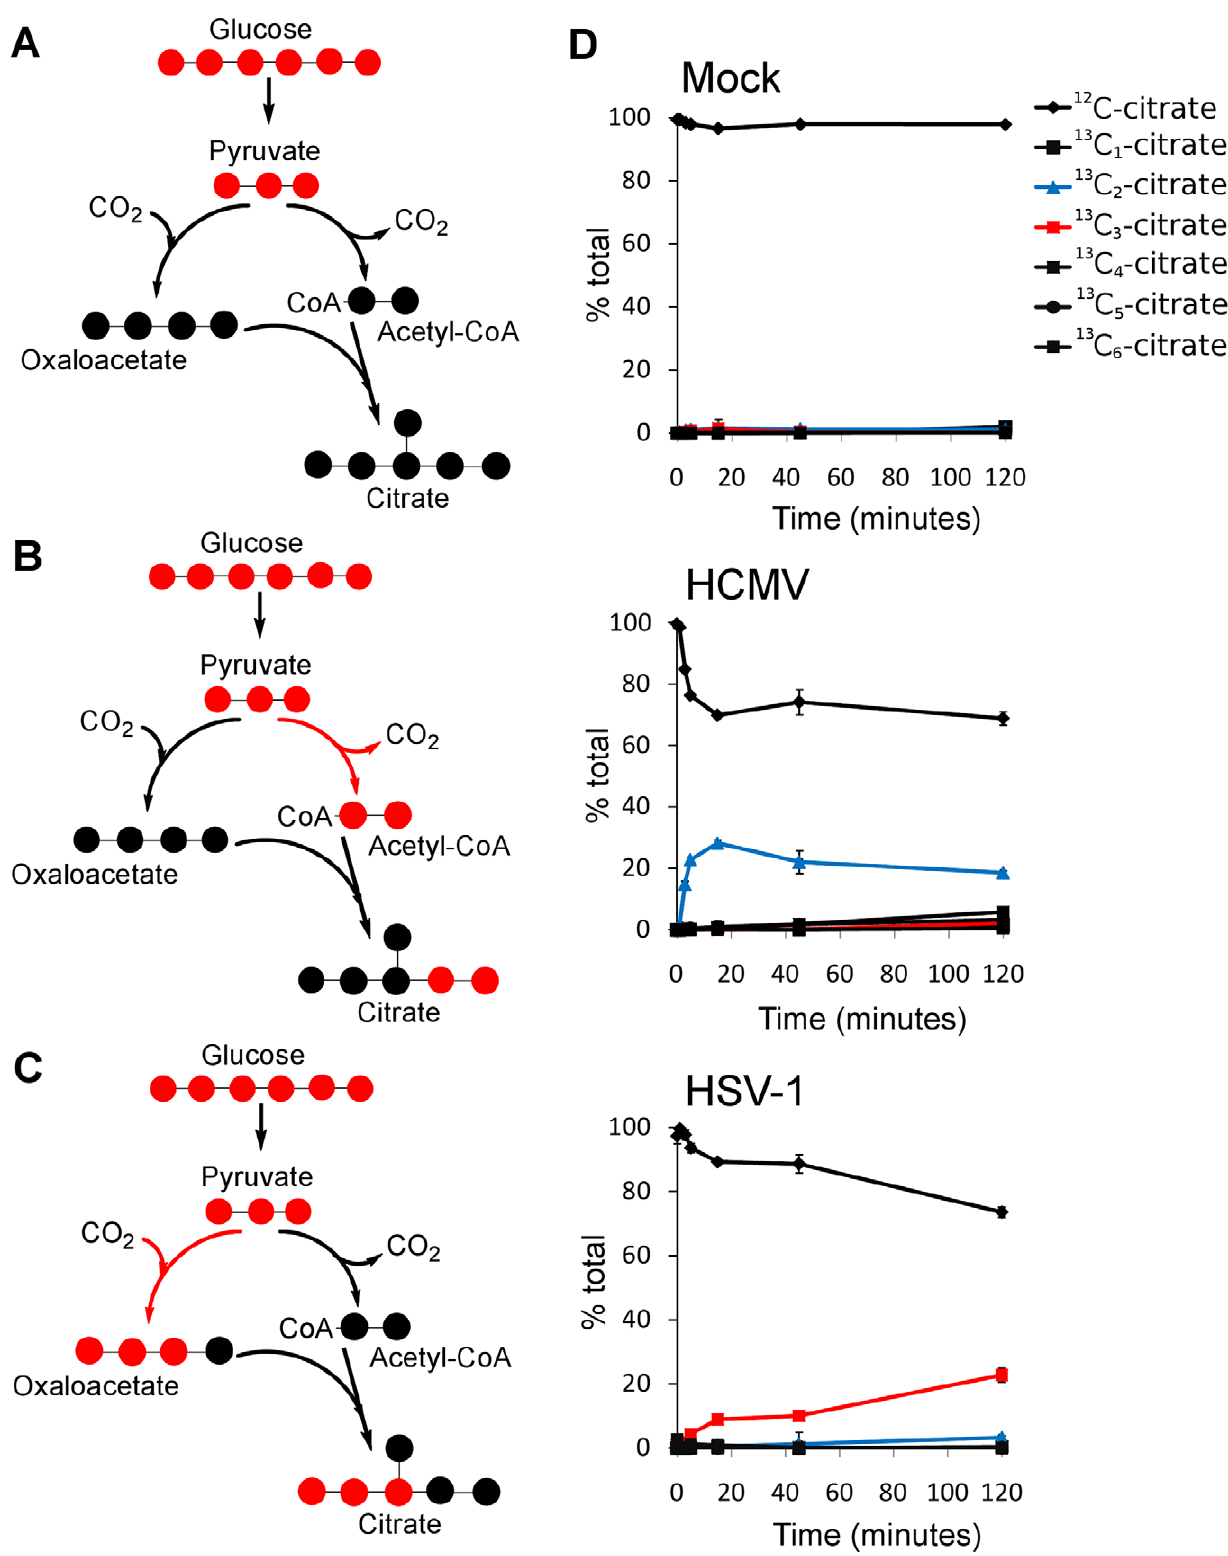
Figure 3. Virus-specific up-regulation of glucose influx to the TCA cycle. The left column of schematic show carbon labeling from glucose to the TCA cycle via pyruvate carboxylase and pyruvate dehydrogenase. Red dots denote 13 C atoms originating from uniformly 13 C-labeled glucose. ( A ) Labeling patterns when neither pyruvate carboxylase nor pyruvate dehydrogenase are active. ( B ) Labeling pattern when carbon influx to the TCA cycle from glucose is via pyruvate dehydrogenase. ( C ) Labeling pattern when carbon influx to the TCA cycle from glucose happens via pyruvate